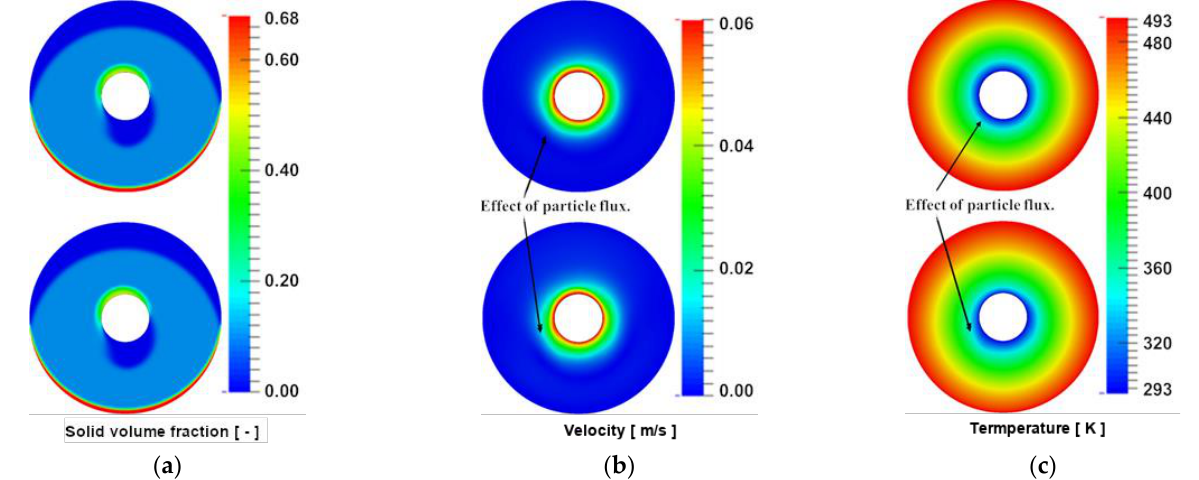
Figure 7. The flow fields at t = 0.2 s. ( a ) Volume fraction of the solid particles; ( b ) Velocity distribution; ( c ) Temperature distribution. The top panels represent the results predicted by Phillips’ model [14], the bottom panels represent the results predicted by the proposed particle flux model.